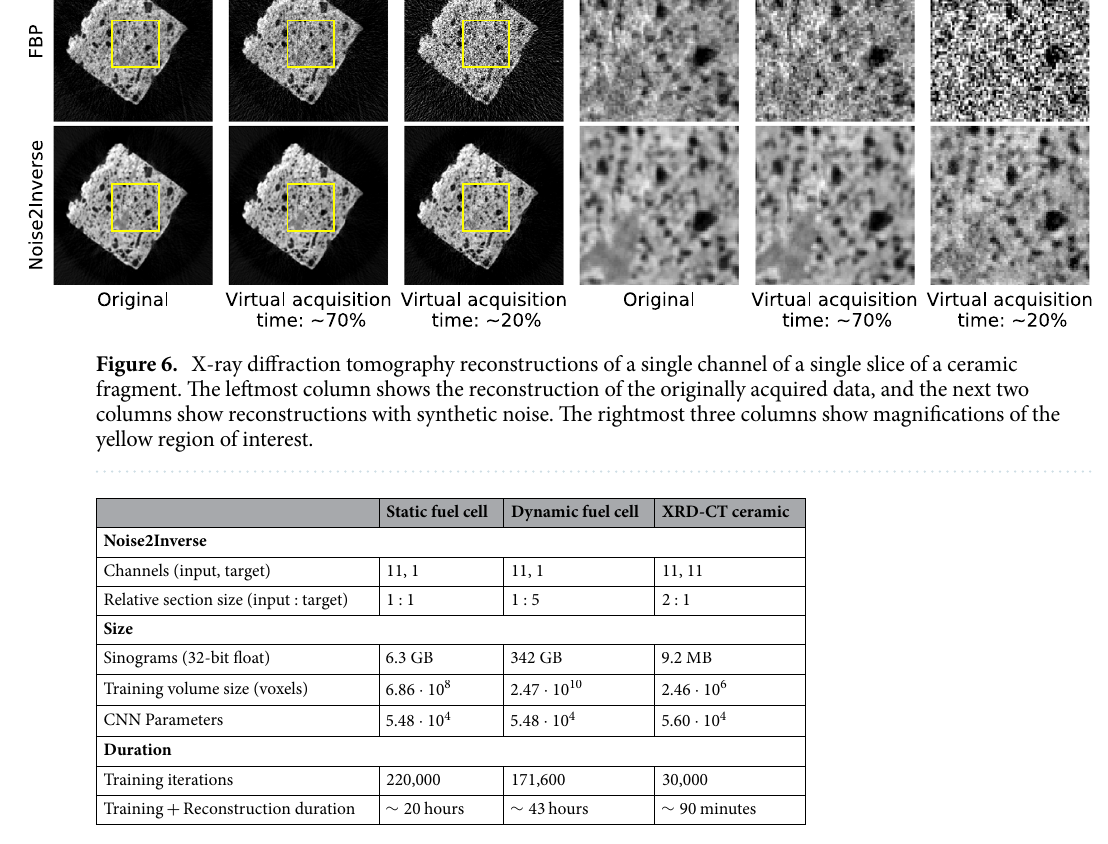
Table 1. Details of Noise2Inverse training on the static and dynamic micro-tomography datasets of a fuel cell and X-ray diffraction tomography dataset of a ceramic. The relative section size reports the ratio of the size of the input section relative to the target section. The size of the training volumes varies widely, whereas the number of parameters in the CNN is stable. Reported training times are indicative, and are specific to the